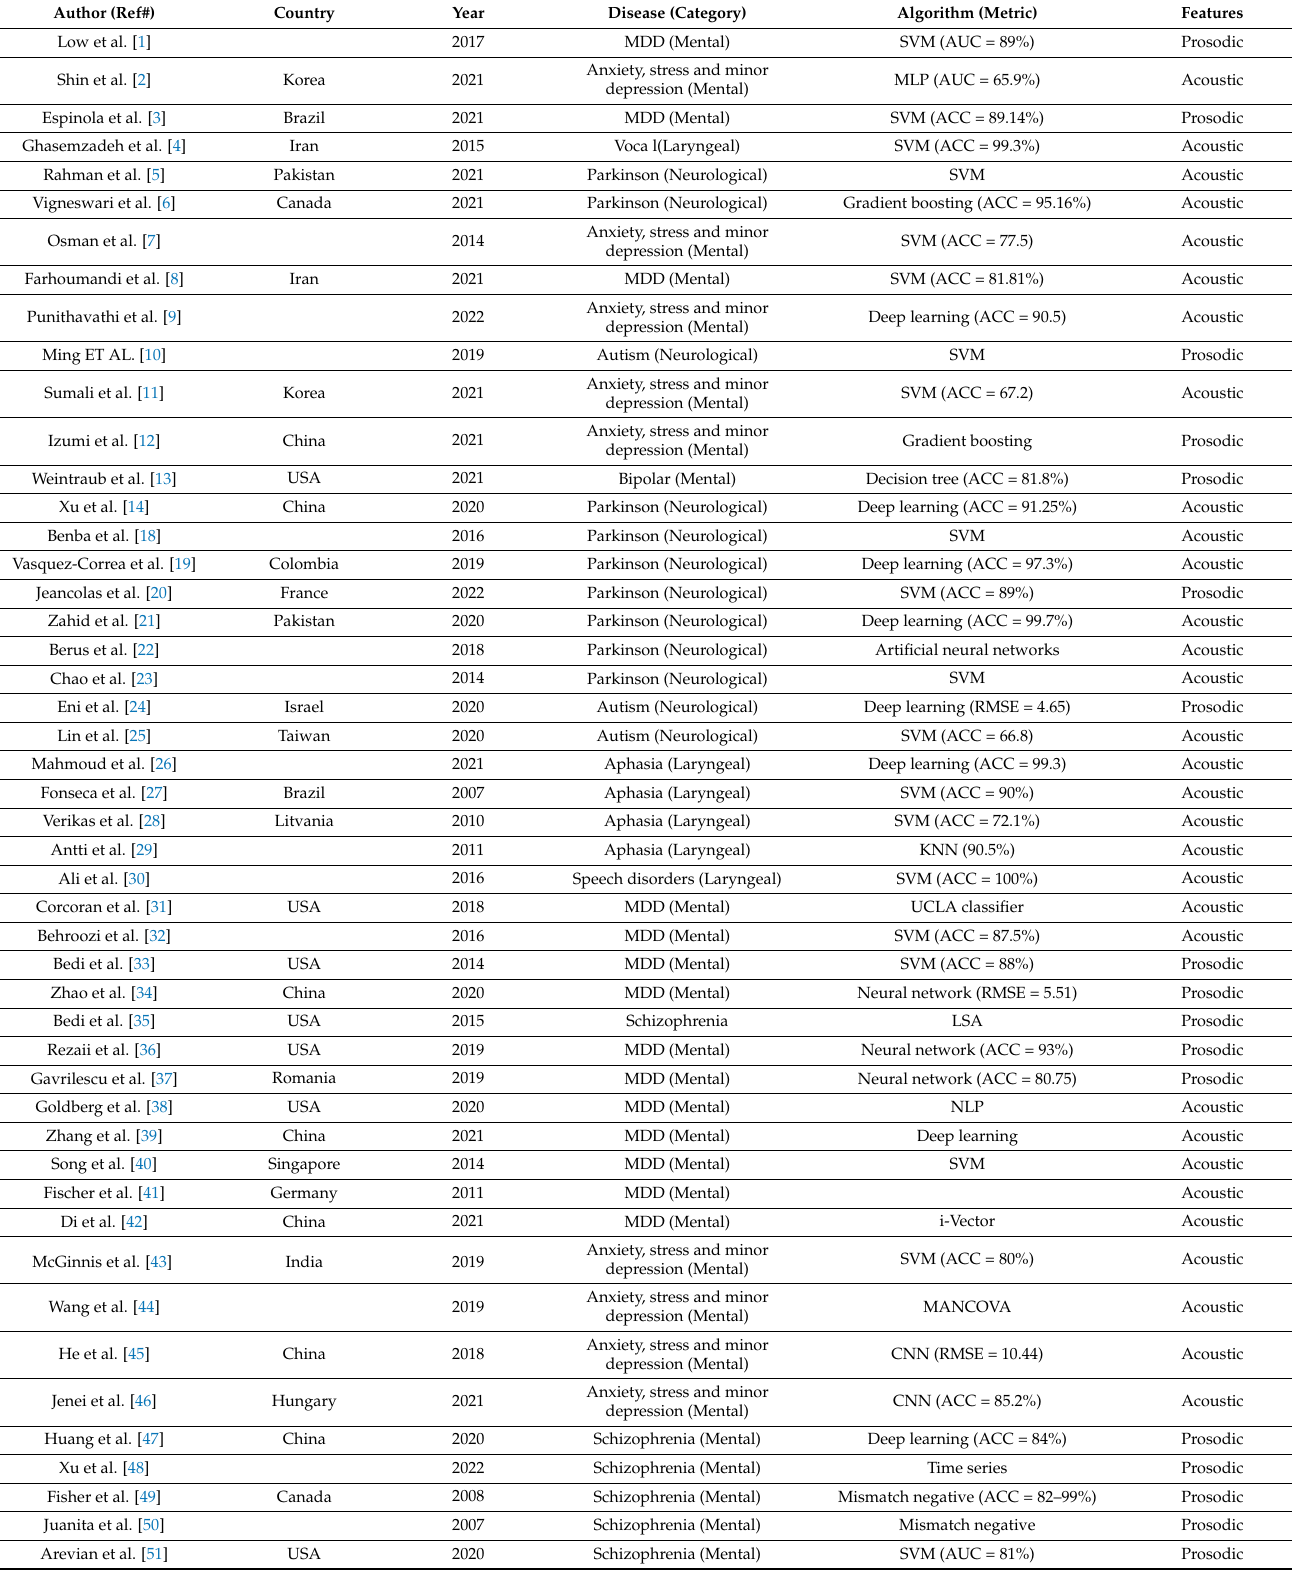
Table 3. Classification of voice features and detection algorithms based on speech